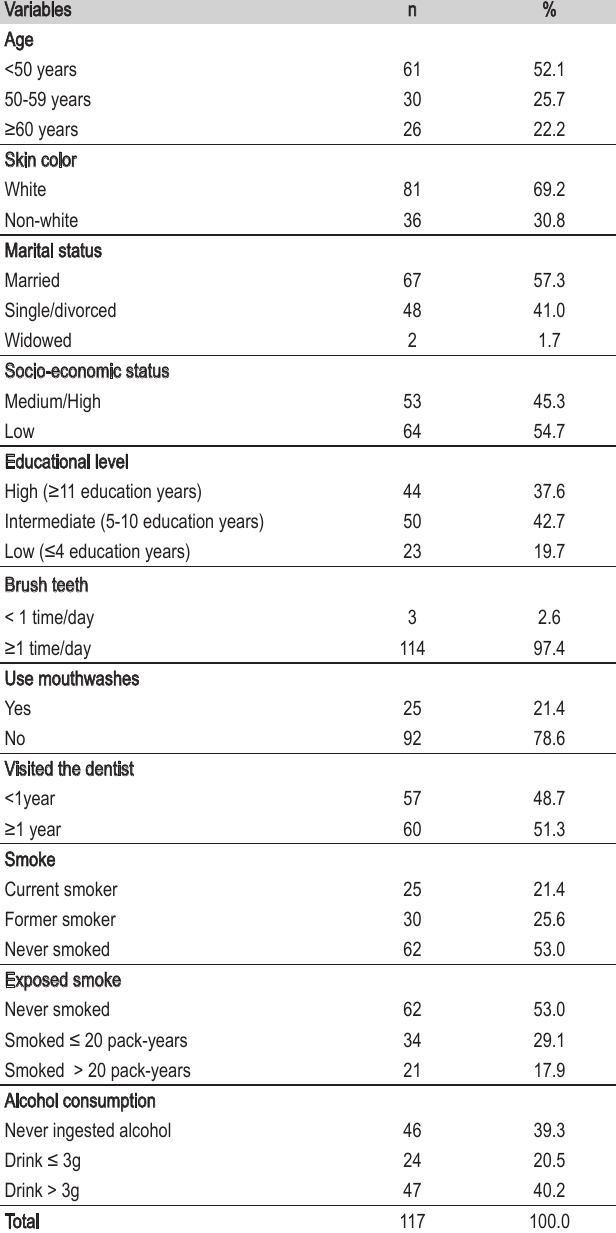
Table 1 - Absolute distribution and percentage of socio- demographic and behavioral status of the